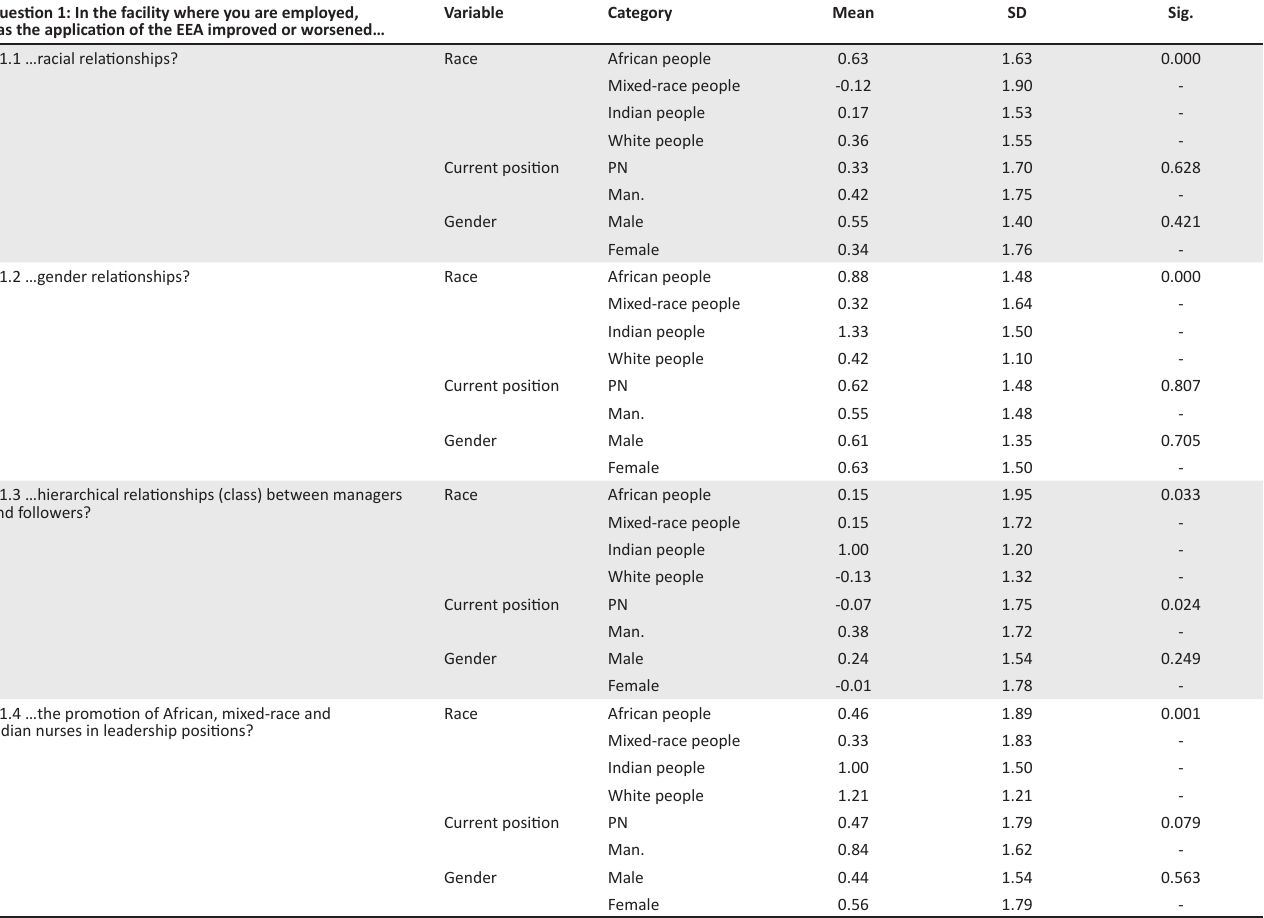
Variable Category Sig.